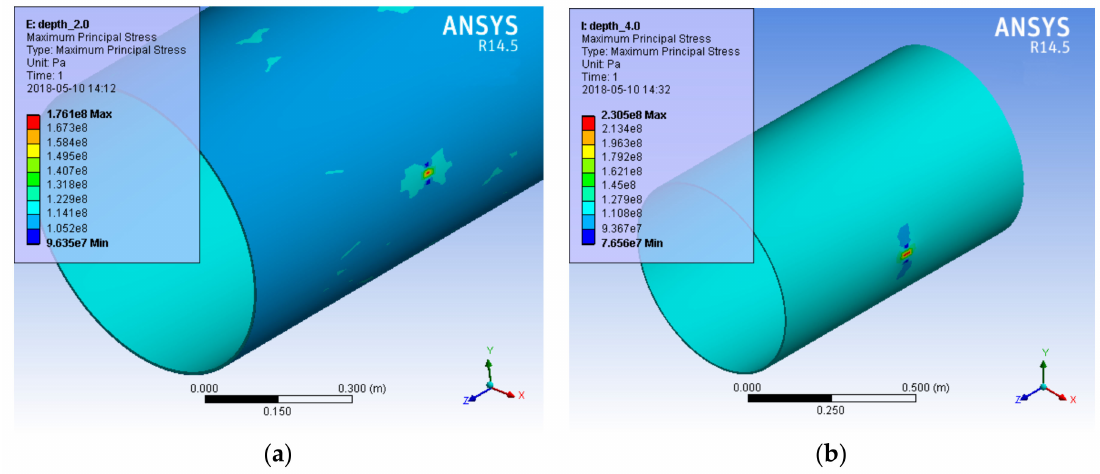
Figure 8. Principal stresses in the pipe with a gouge of various depths: ( a ) 2.0 mm; ( b ) 4.0 mm.